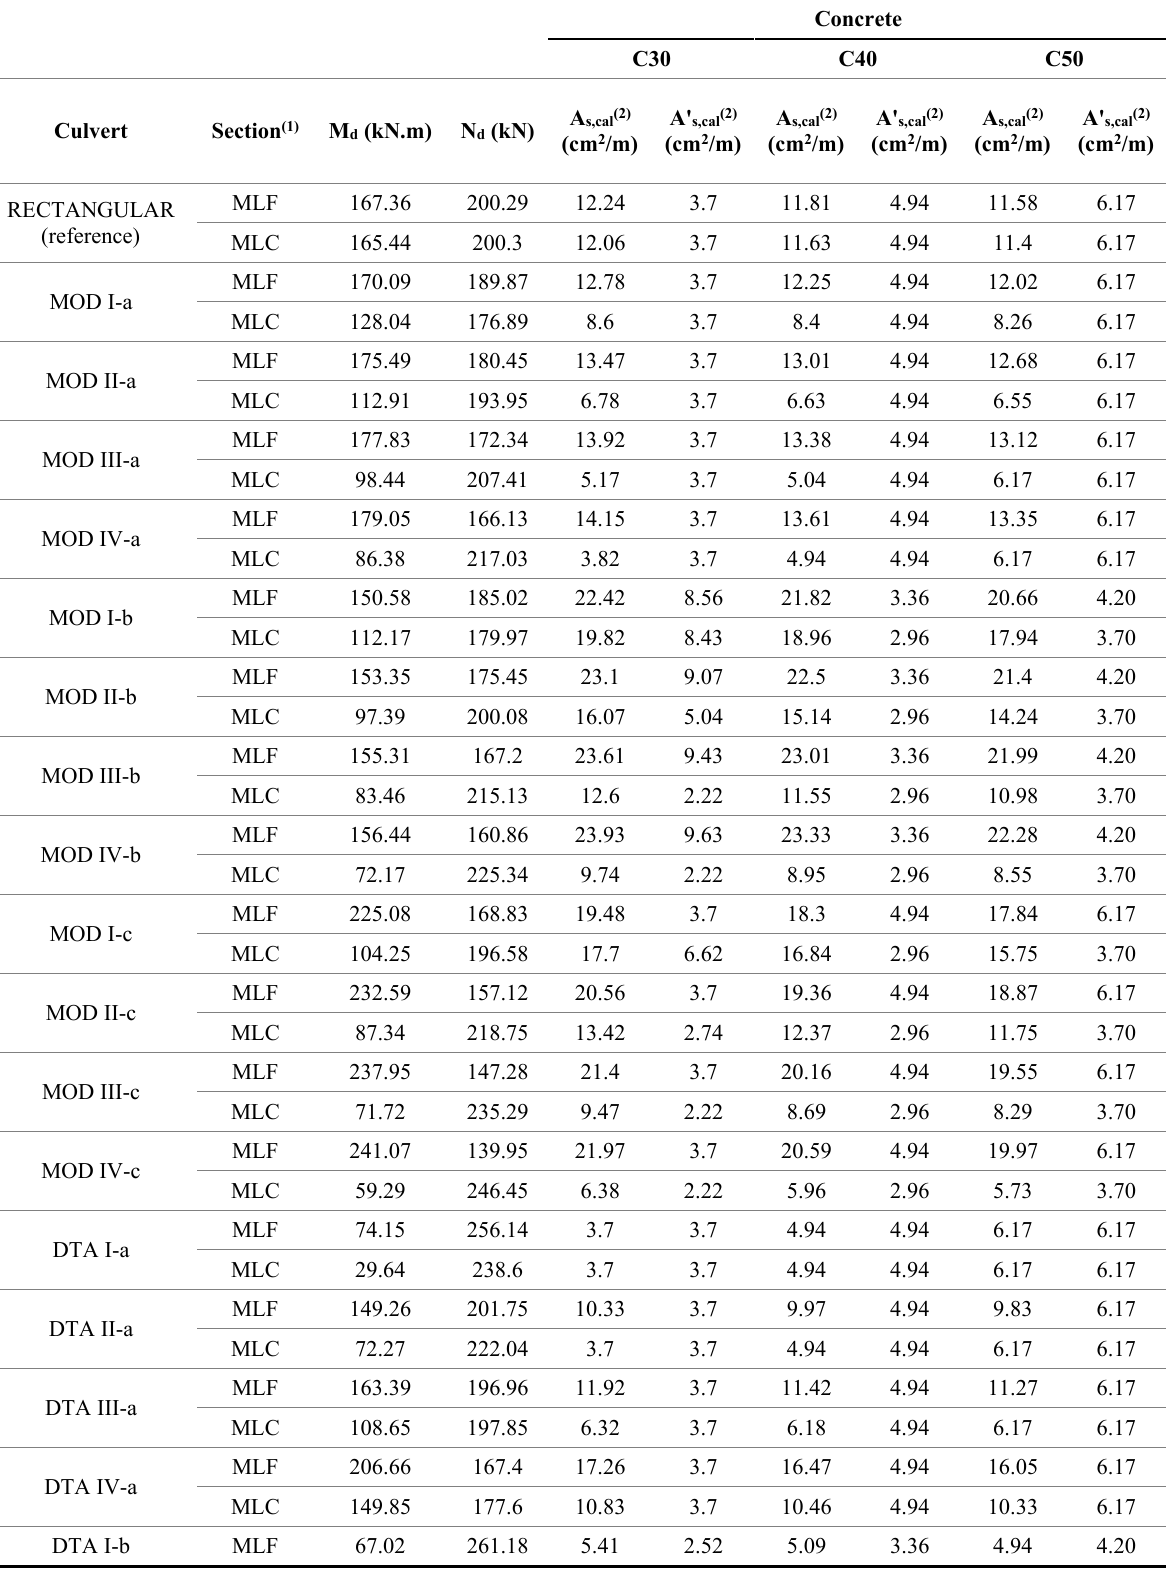
Table 5. Longitudinal reinforcement for critical sections MLF and MLC.